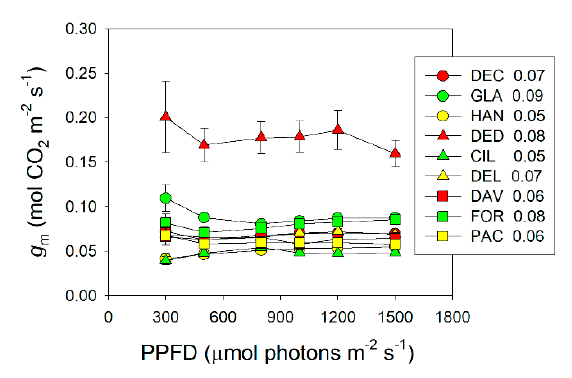
Figure 1. Responses of the leaf CO 2 assimilation rate ( A N ) and electron transport rate ( J PSII ) to incident photosynthetic photon flux density (PPFD) in nine Rhododendron species. Symbols represent means ± SE ( n = 4–5).